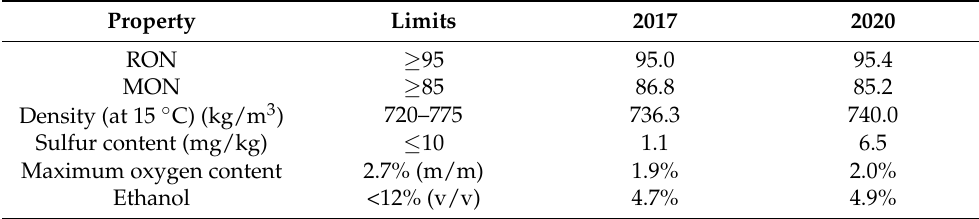
Table 2. EN 228-compliant fuel specifications.